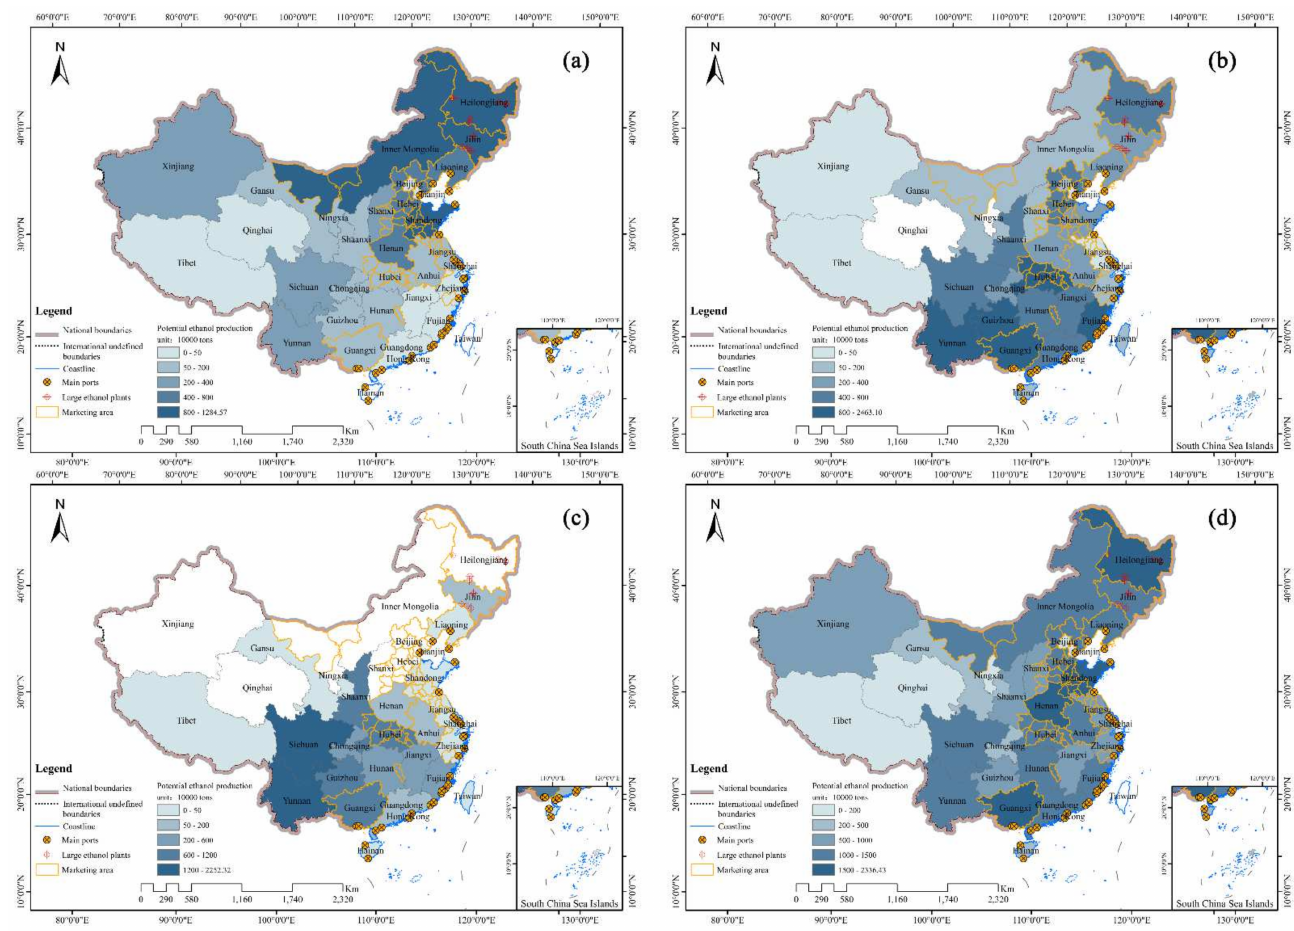
Figure 4. The distribution of provincial bioethanol yield potential in three stages in China: ( a ) first stage; ( b ) second stage; provincial yield potential based on ( c ) switchgrass in the third stage; and ( d ) crop straws and forest residues in the third